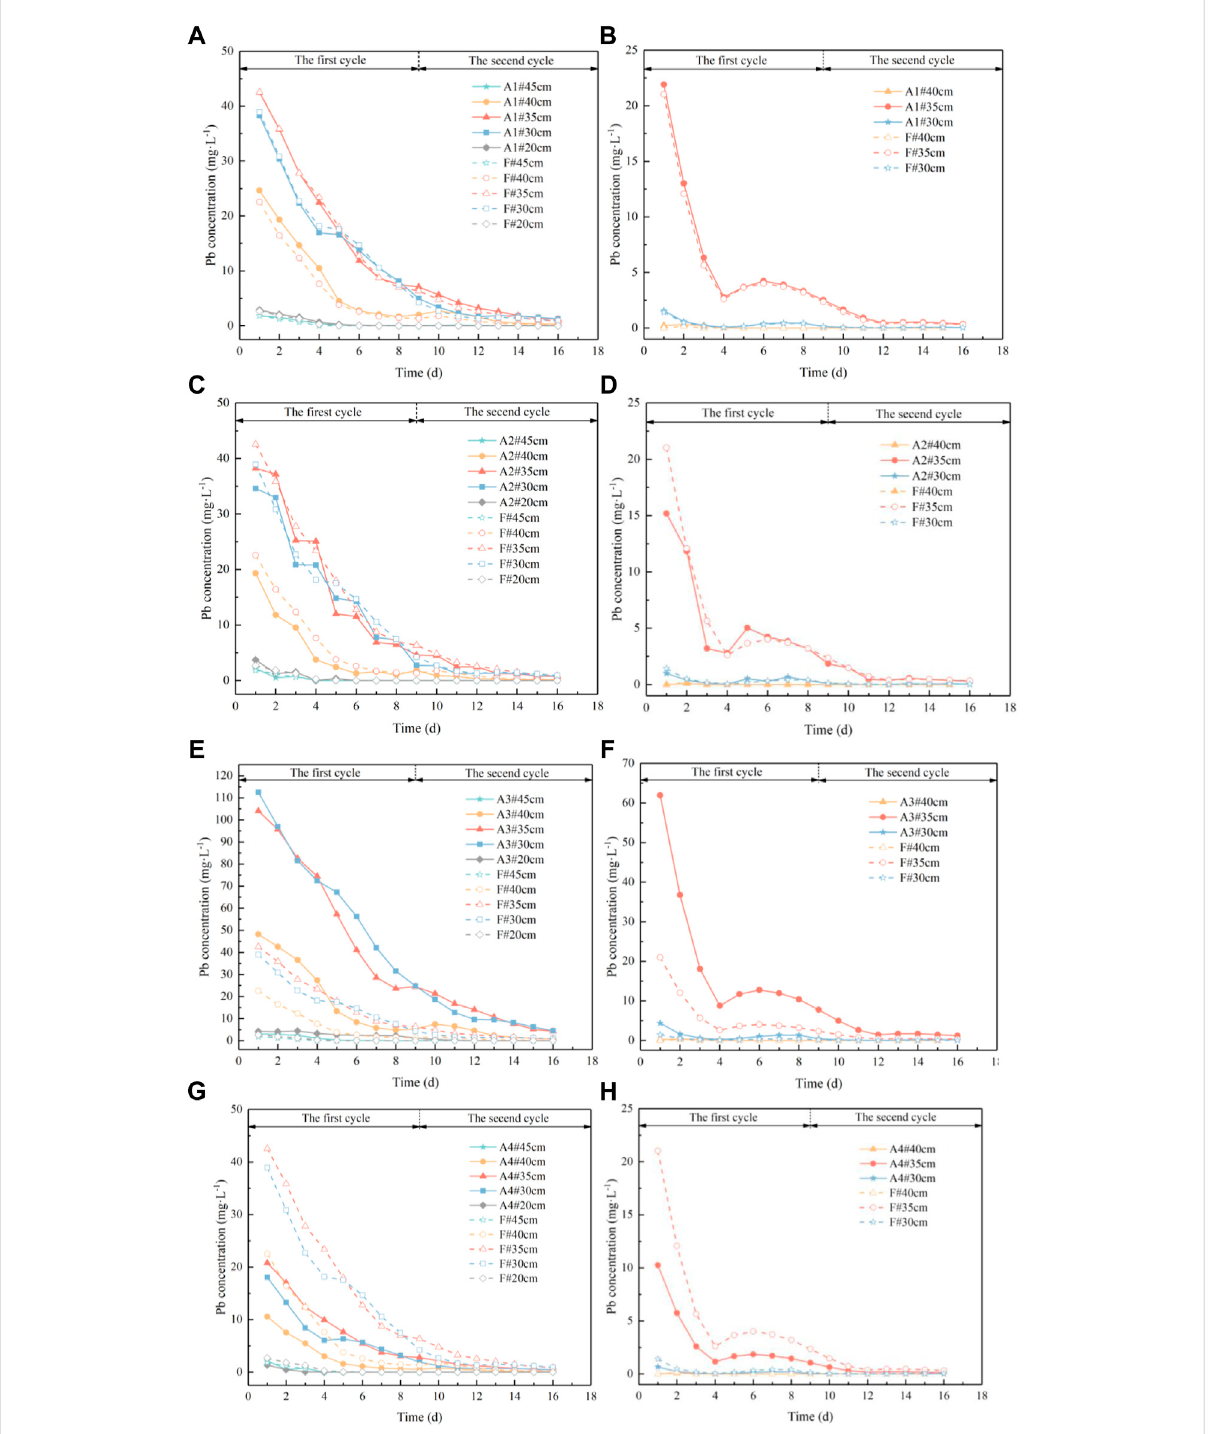
FIGURE 6 Pb concentration change process in water of soil column. (A) : Variation of Pb concentration in water of coarse sand column in scenario 1; (B) : variation of Pb concentration in water of medium sand column in scenario 1; (C) : variation of Pb concentration in water of coarse sand column in scenario2; (D) :variationofPbconcentrationinwaterofmediumsandcolumninscenario2; (E) :variationofPbconcentrationinwaterofcoarsesand column in scenario 3; (F) : variation of Pb concentration in water of medium sand column in scenario 3; (G) : variation of Pb concentration in water of coarse sand column in scenario 4; (H) : variation of Pb concentration in water of medium sand column in scenario